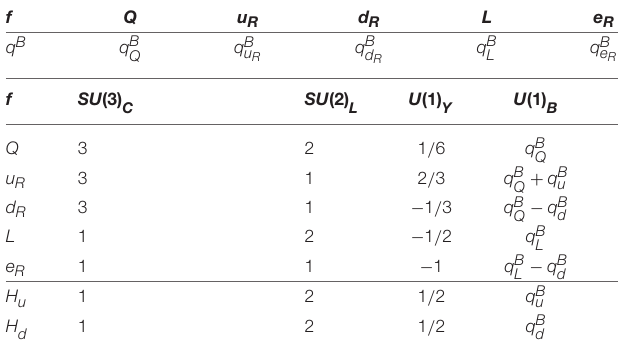
TABLE 1 | Charges of the fermion and of the scalar